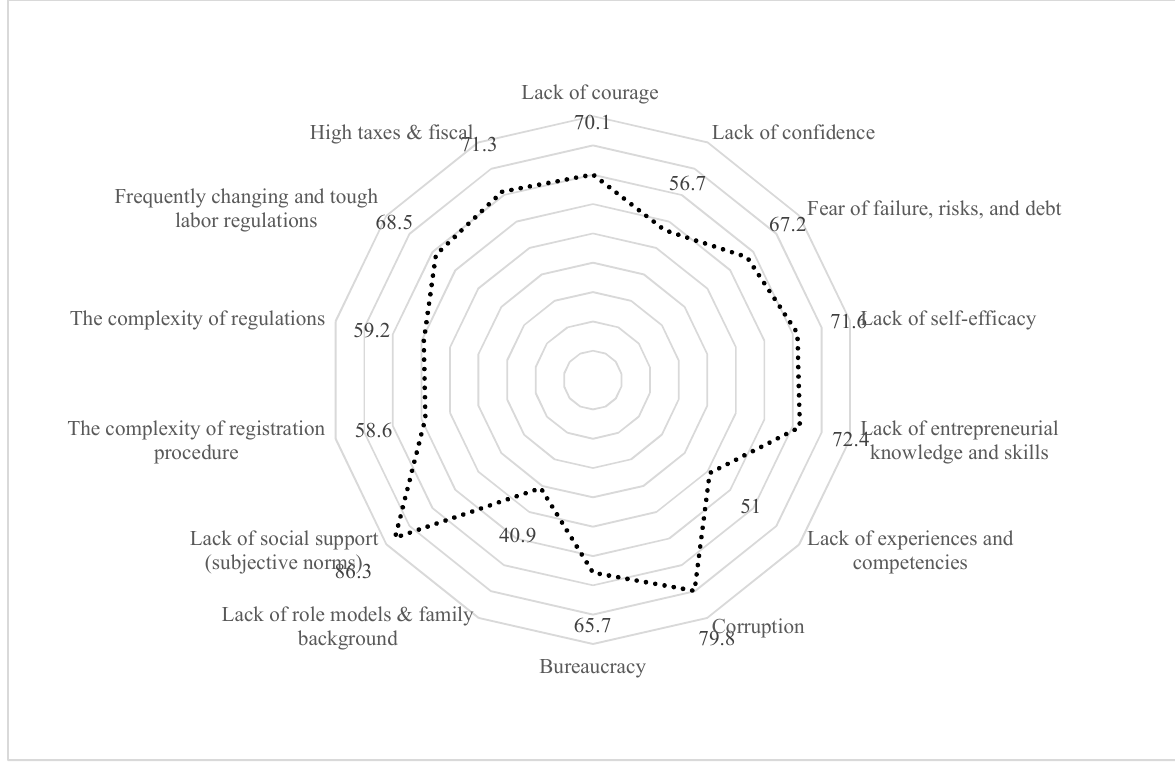
Fig 3 . Evaluation of respondents regarding to entrepreneurial barriers